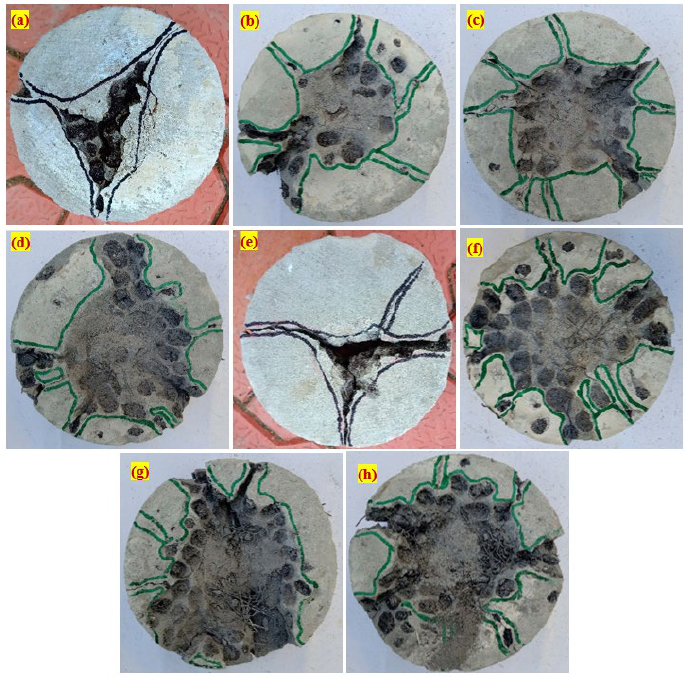
Figure 8. Failure mode of specimens subjected to impact load ( a ) C0.1, ( b ) G1-C0.1, ( c ) G2-C0.1, ( d ) G3-C0.1, ( e ) C0.2, ( f ) G1-C0.2, ( g ) G2-C0.2, ( h ) G3-C0.2.